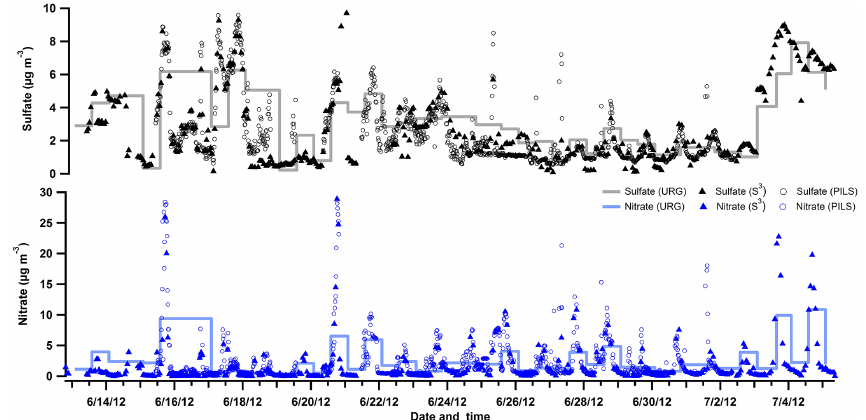
Figure 4. Time series of PM 2 . 5 nitrate and sulfate collected from June to July 2012 in San Gorgonio Wilderness area, CA, using one S3 sampler, the PILS-IC, and URG